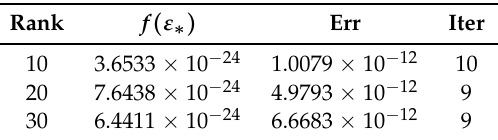
Table 2. Computational results from recovering three matrices of different ranks and 30% of known entries. The dimension is always 1000 × 1000.